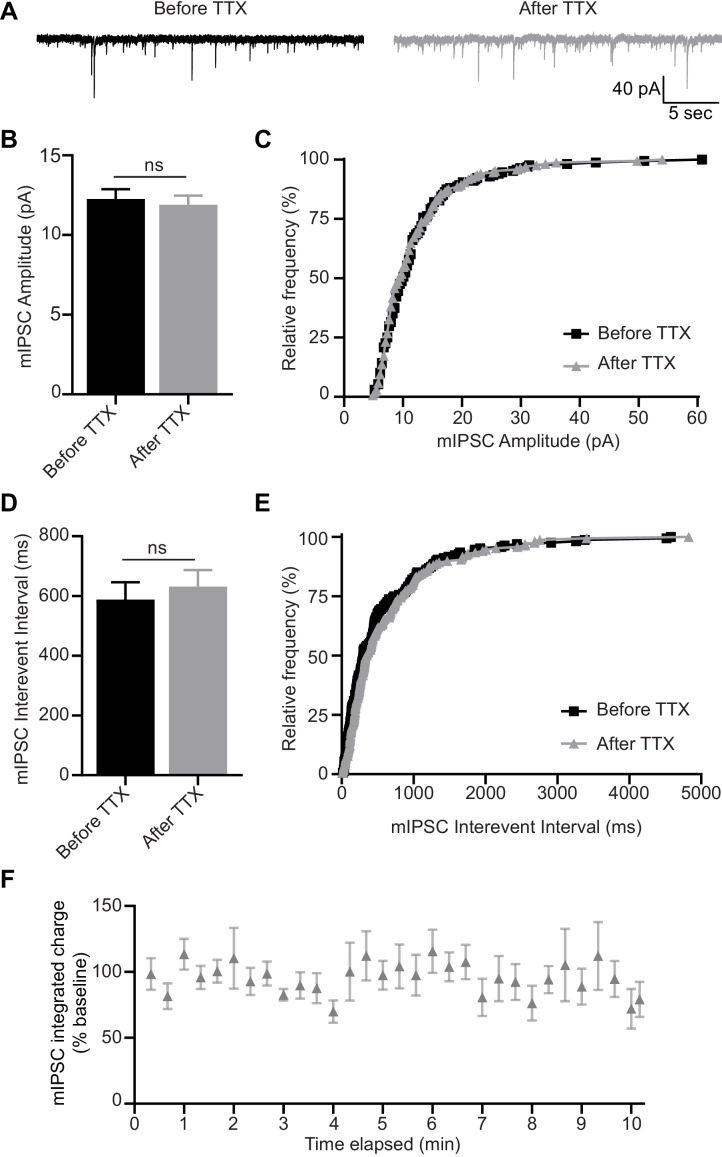
Detected spontaneous events are unaffected by TTX application.(A) Example traces of spontaneous events before (left, black) and after (gray, right) TTX application. (B) Average amplitude of detected spontaneous inhibitory events (i.e. in the absence of stimulation) before and 10 min after TTX application. Amplitude of detected events is unaltered by TTX addition (unpaired t-test t(334) = 0.4353, p=0.6636, n = 168 events from seven recordings, 21 events randomly selected per recording). (C) Cumulative histogram plot of amplitudes of detected spontaneous inhibitory events before and after TTX. (D) Average interevent interval of detected spontaneous inhibitory events (i.e. in the absence of stimulation) before and 10 min after TTX. Interevent interval is unaltered by TTX addition (unpaired t-test t(334) = 0.5429, p=0.5876, n = 168 events from seven recordings, 21 intervals randomly selected per recording). (E) Cumulative histogram plot of interevent intervals of detected spontaneous inhibitory events before and after TTX. TTX application did not affect spontaneous event amplitudes or frequencies, indicating spontaneously recorded events are bona fide mIPSCs. (F) Time course of mIPSC events following application of TTX. mIPSCs are unaffected by metabolic rundown seen in evoked recordings. Graphs are mean ± SEM. ns indicates not significant.Figure 3—figure supplement 1—source data 1.Source data for Figure 3—figure supplement 1.